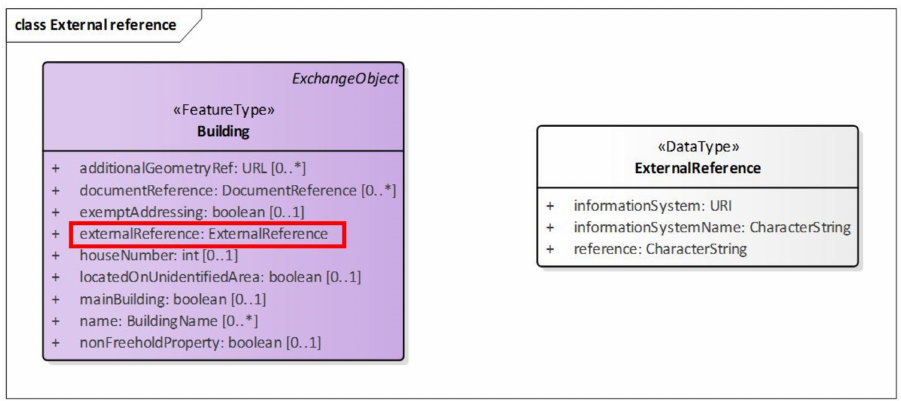
Figure 6. External referencing in NS Building; the attribute is marked in a red box (model translated from Swedish by the